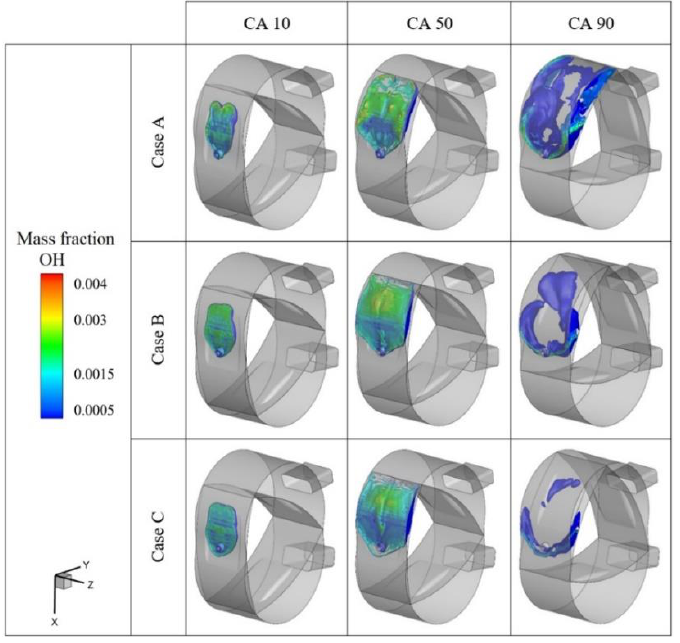
Figure 13. Iso-surfaces of OH mass fraction in the combustion chamber for different cases at CA 10, CA 50 and CA 90.